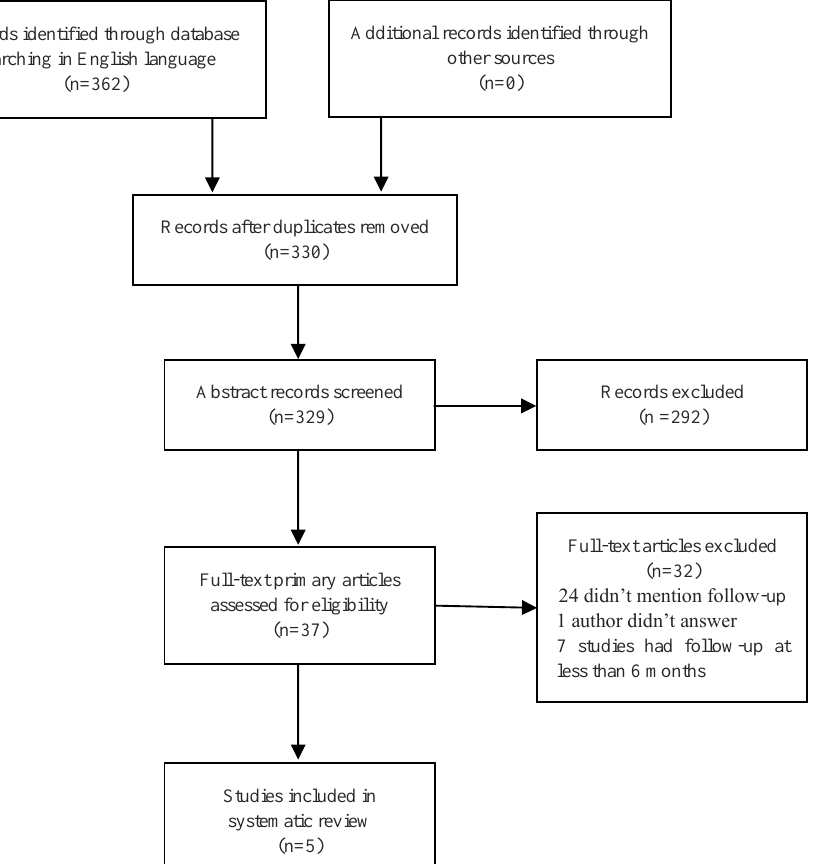
Records identified through database searching in English